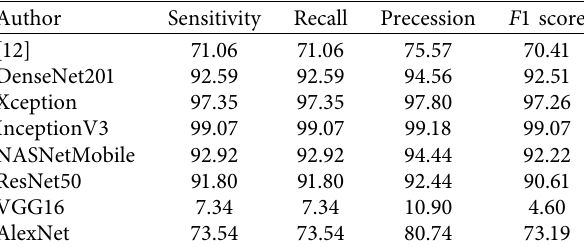
Table 4: Comparison with recent